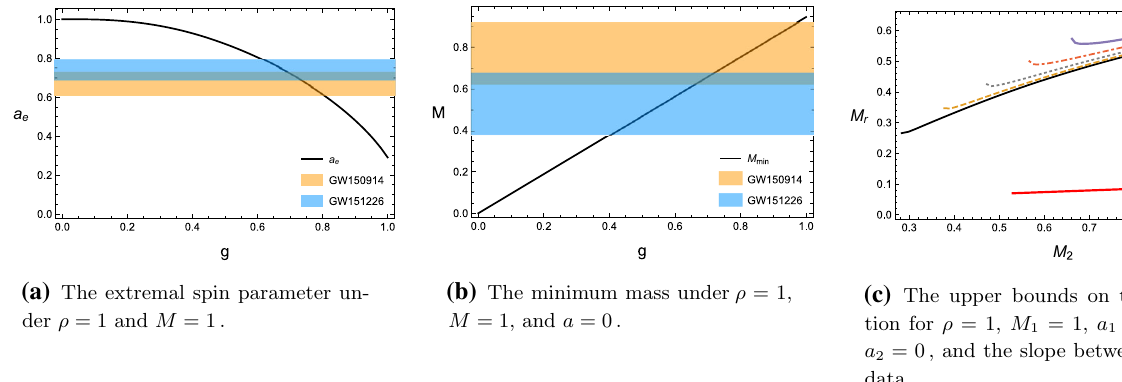
Fig. 15 The upper bounds thermally allowed and detections of the LIGO